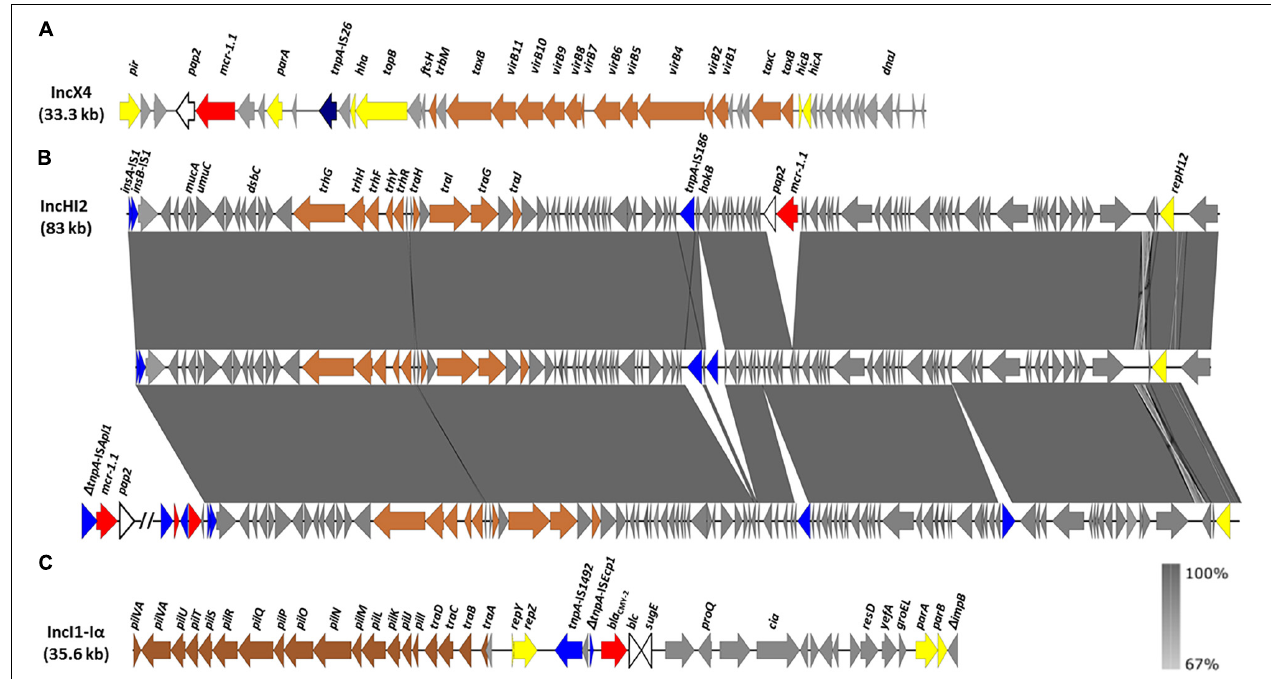
FIGURE 2 | Genetic environment of the mcr-1.1 and bla CMY − 2 genes detected in food-borne isolates of the European monophasic clone. (A) Genetic context of mcr-1.1 carried by IncX4 plasmids in the LSP 237/15, LSP 295/15, and LSP 298/15 isolates. (B) Genetic organization of a ca. 83 kb contig carrying the mcr-1.1 gene in the IncHI2 plasmid of LSP 38/19. The alignment of this contig with homologous regions in two related plasmids either lacking mcr-1.1 (pKUSR18; accession number KM396298) or having the gene outside this region (pSE08-00436-1; accession number NZ_CP020493) was created with EasyFig BLASTn. The gray shading between the regions reflects nucleotide sequence similarity ranging from 67 to 100%, according to the scale shown at the lower right part of the figure. (C) Genetic environment of the bla CMY − 2 gene in a 35.6 kb contig of the IncI1-I( α ) plasmid of LSP 38/19. The open reading frames (ORFs) are represented by arrows pointing to the direction of transcription and having different colors according to their function: red, resistance; yellow, plasmid replication, stability and maintenance; brown, conjugation; blue, DNA mobility, with the tnpA gene of IS 26 shown in dark blue; gray, other roles; white, pap2 , adjacent to mcr-1.1 in the IncX4 and IncHI2 plasmids, and bcl - sugE , adjacent to bla CMY − 2 in the IncI1-I( α ) plasmid. The scale is different for (A–C)